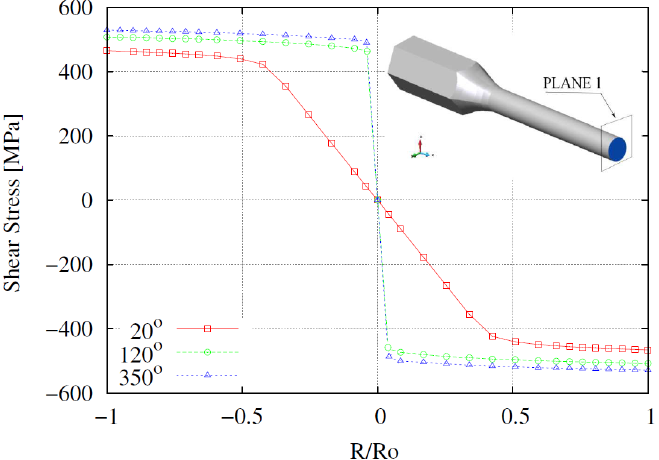
Figure 16. Numerical radial profiles for the shear stress σ z θ in plane 1 for different torsion